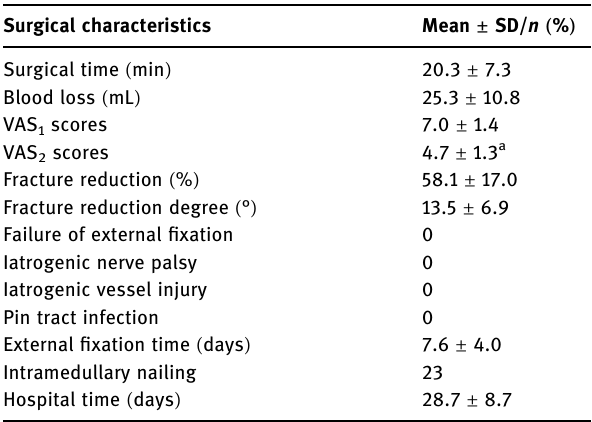
Table 2: Surgical